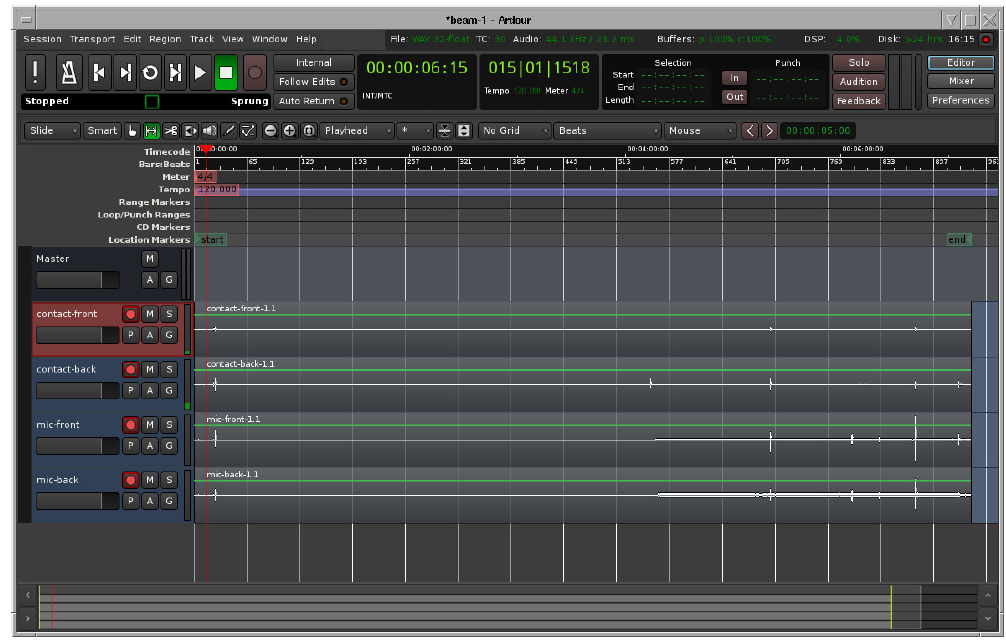
Fig. 9. An example recording of the 4 microphones shown is the entire recording for a fibre-beam (f01). At the beginning of the recording the syncronization click is visible, all other peaks belong to crack